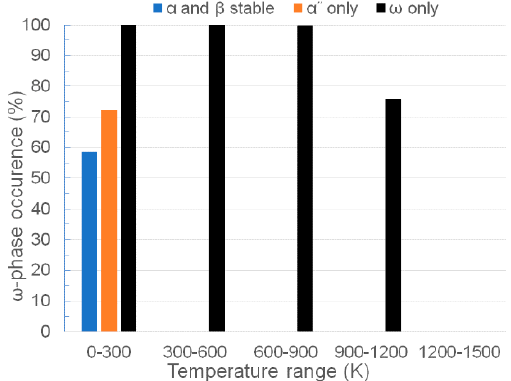
Figure 1. Occurrence (%) of the OMEGA ( ω ) phase for different temperature ranges for three separate equilibrium calculations.